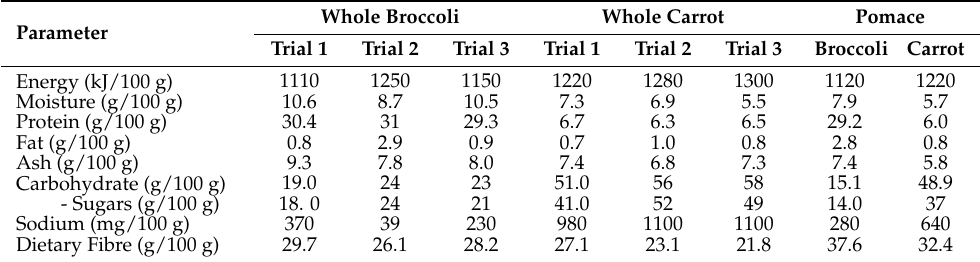
Table 2. Typical composition of powders produced from Trials 1, 2 and 3.